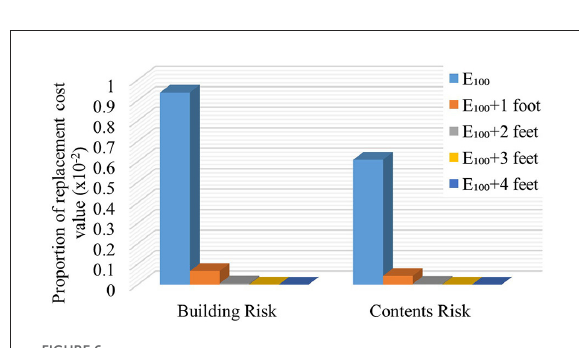
FIGURE5 AAL for building, contents, and use by owner/occupant type at 100-year flood elevation, if all homes would be in the same owner/occupant